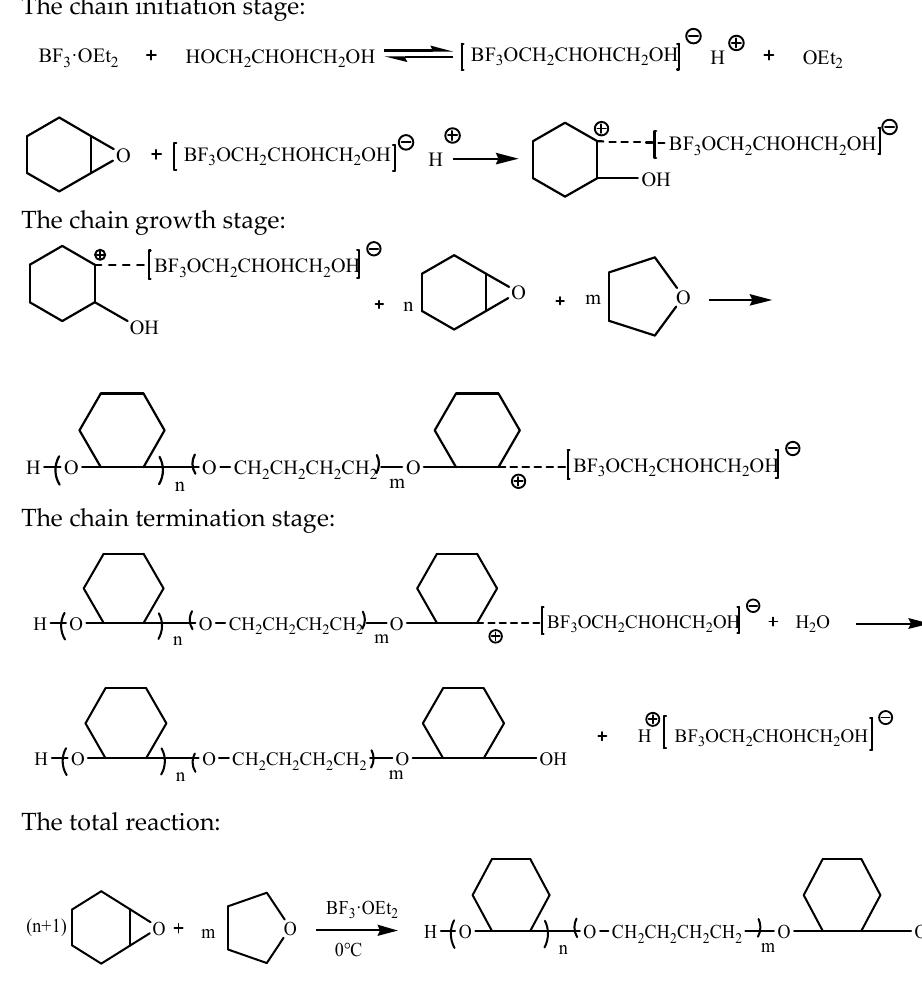
Scheme 1. Reaction mechanism of the CHO-THF copolyether.